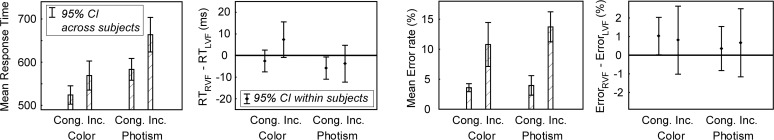
Alternative analysis, considering long RTs as errors.
(a,b) For each subject and condition, the central tendency of the RT distribution was estimated using the mean of the log values, after removing outliers to the distribution (see text). We computed group analyses on the exponential of this mean value. The results are similar to those based on the inverse transformation (no outlier removal), shown in Fig. 2. (c,d) Outliers were added to the few errors and all were considered as errors for the purpose of the analysis. In contrast with response times, the hemifield differences for error rates were similar in all conditions, with slightly more errors on the right side overall (on average, each subject made one more error on the right side in each experiment; p = 0.03, CI [0.1 1.3] %).